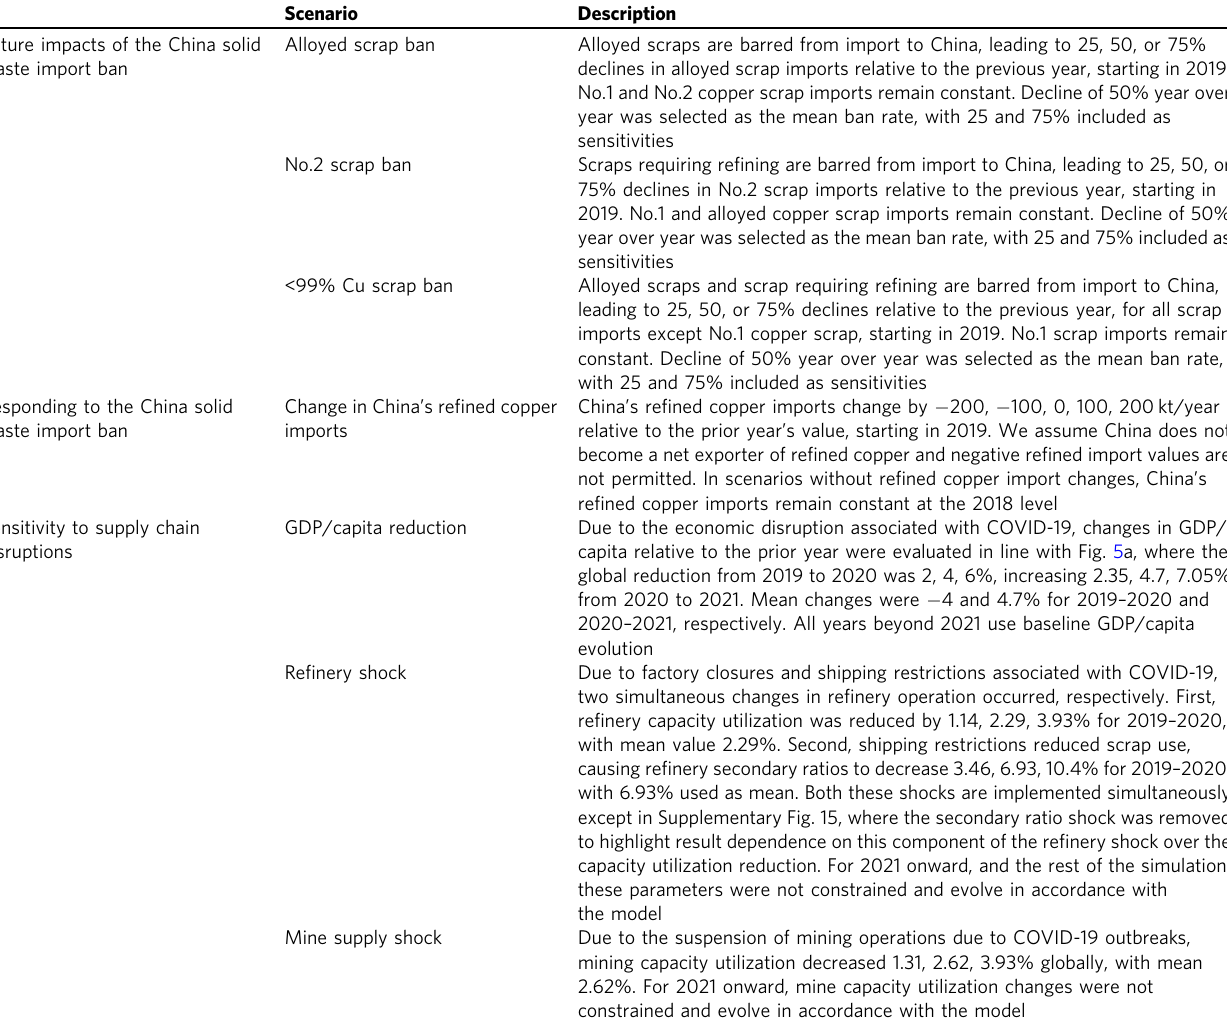
Table 1 Scenario